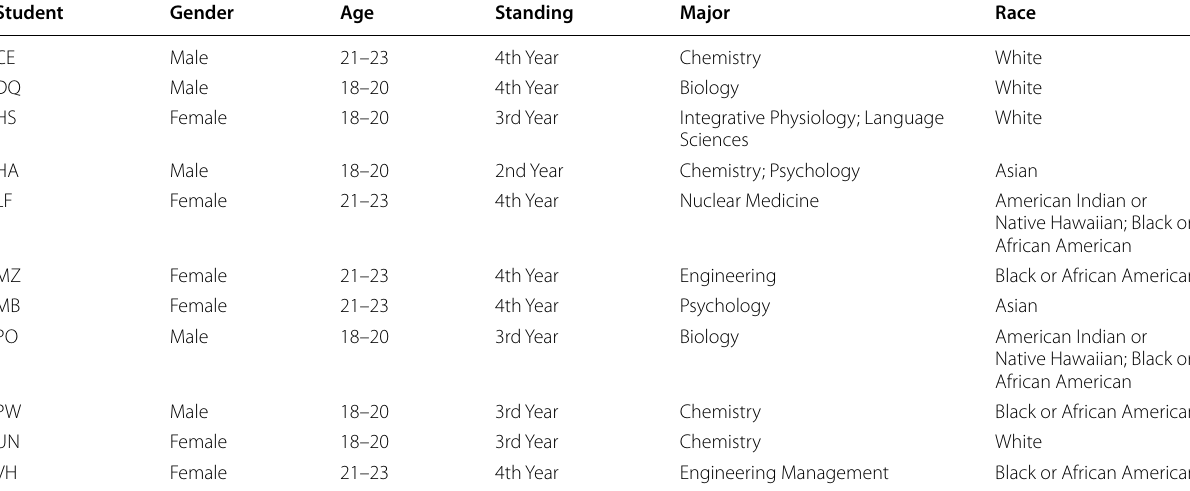
None of the individuals in the sample identified as